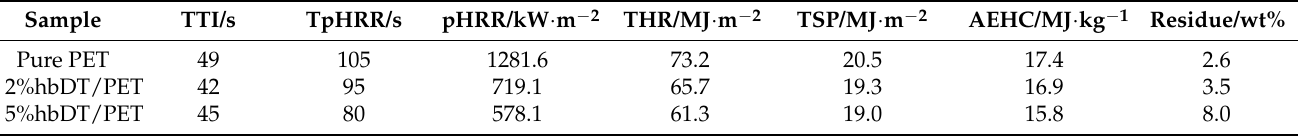
Table 3. The cone calorimeter parameters of pure PET and hbDT/PET